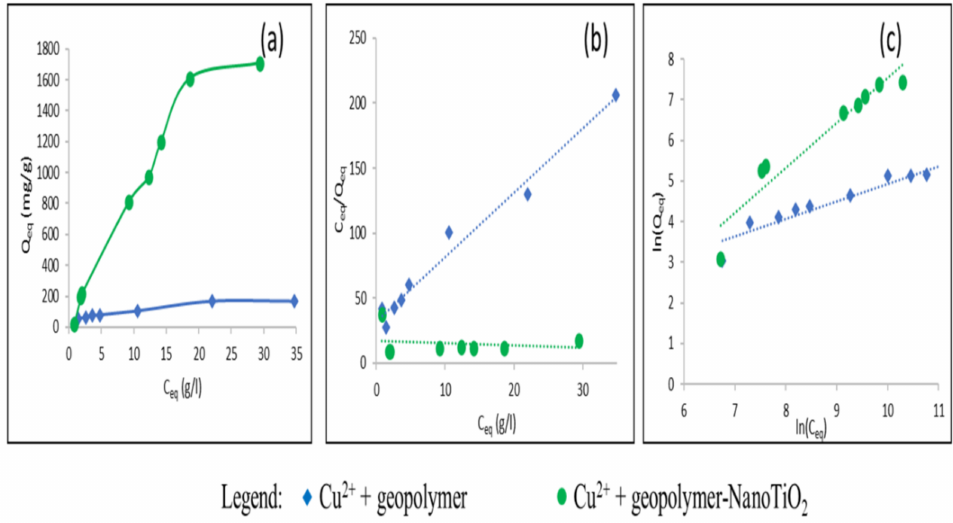
Figure 6. ( a ) Adsorption isotherm of Cu 2+ on geopolymer and geopolymer-NanoTiO 2 composite (volume (15 mL), mass of adsorbent (0.3), pH (6.8), ambient temperature, and stirring speed (250 rpm)), ( b ) Langmuir model, ( c ) Freundlich model.